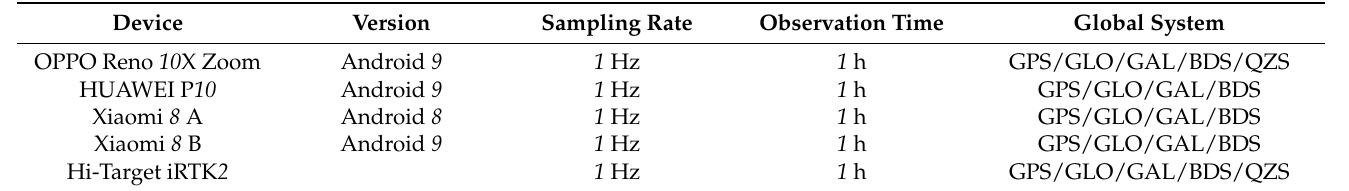
Table 1. Equipment related parameters and experimental settings.